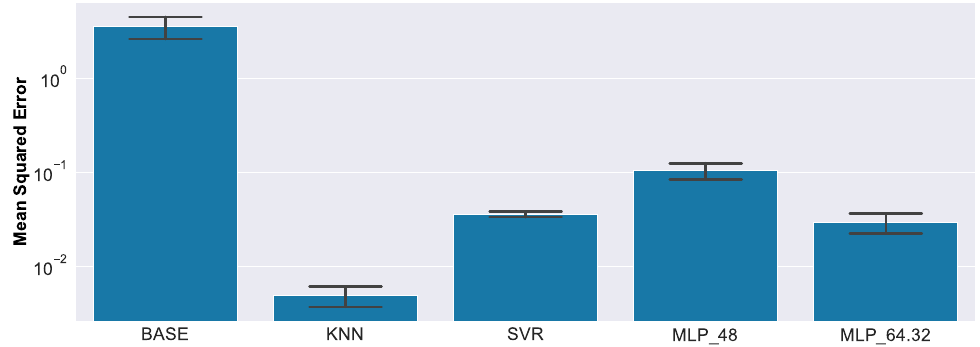
Figure 17. Regression results on synthetic data. Note the logarithmic scale on the y -axis. Compared to the baseline (BASE), all methods gave substantially better results, whereas the nearest-neighbor-based method (KNN) yielded the smallest overall MSE.